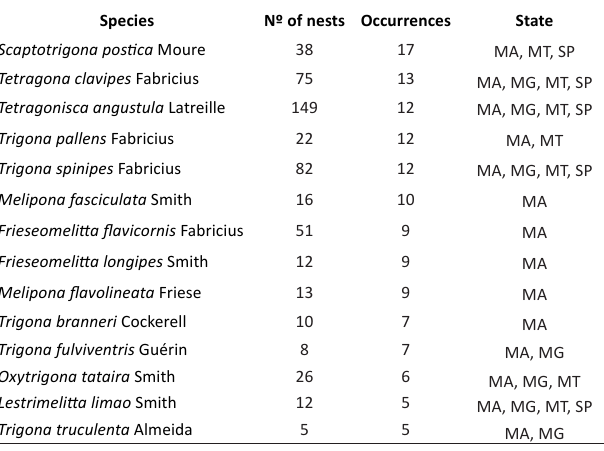
Table 2. Species that were found in five or more surveys. Nº of nests: total of nests found in all surveys; occurrences: number of surveys where species are found; State: Brazilian state where species were found. MA: Maranhão state; MG: Minas Gerais state; MT: Mato Grosso state; SP: São Paulo state.